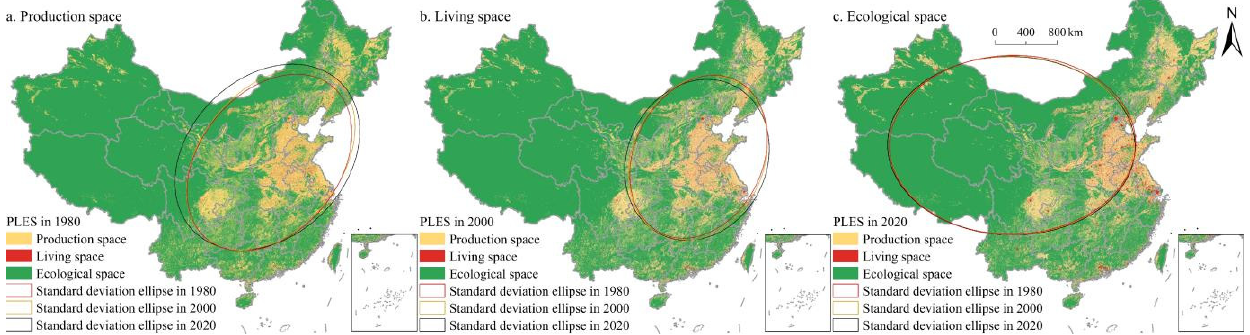
Figure 8. Standard deviation ellipse of PLES pattern in China during 1980 – 2020. Table 3. Standard deviation ellipse parameter of PLES pattern during 1980 – 2020.